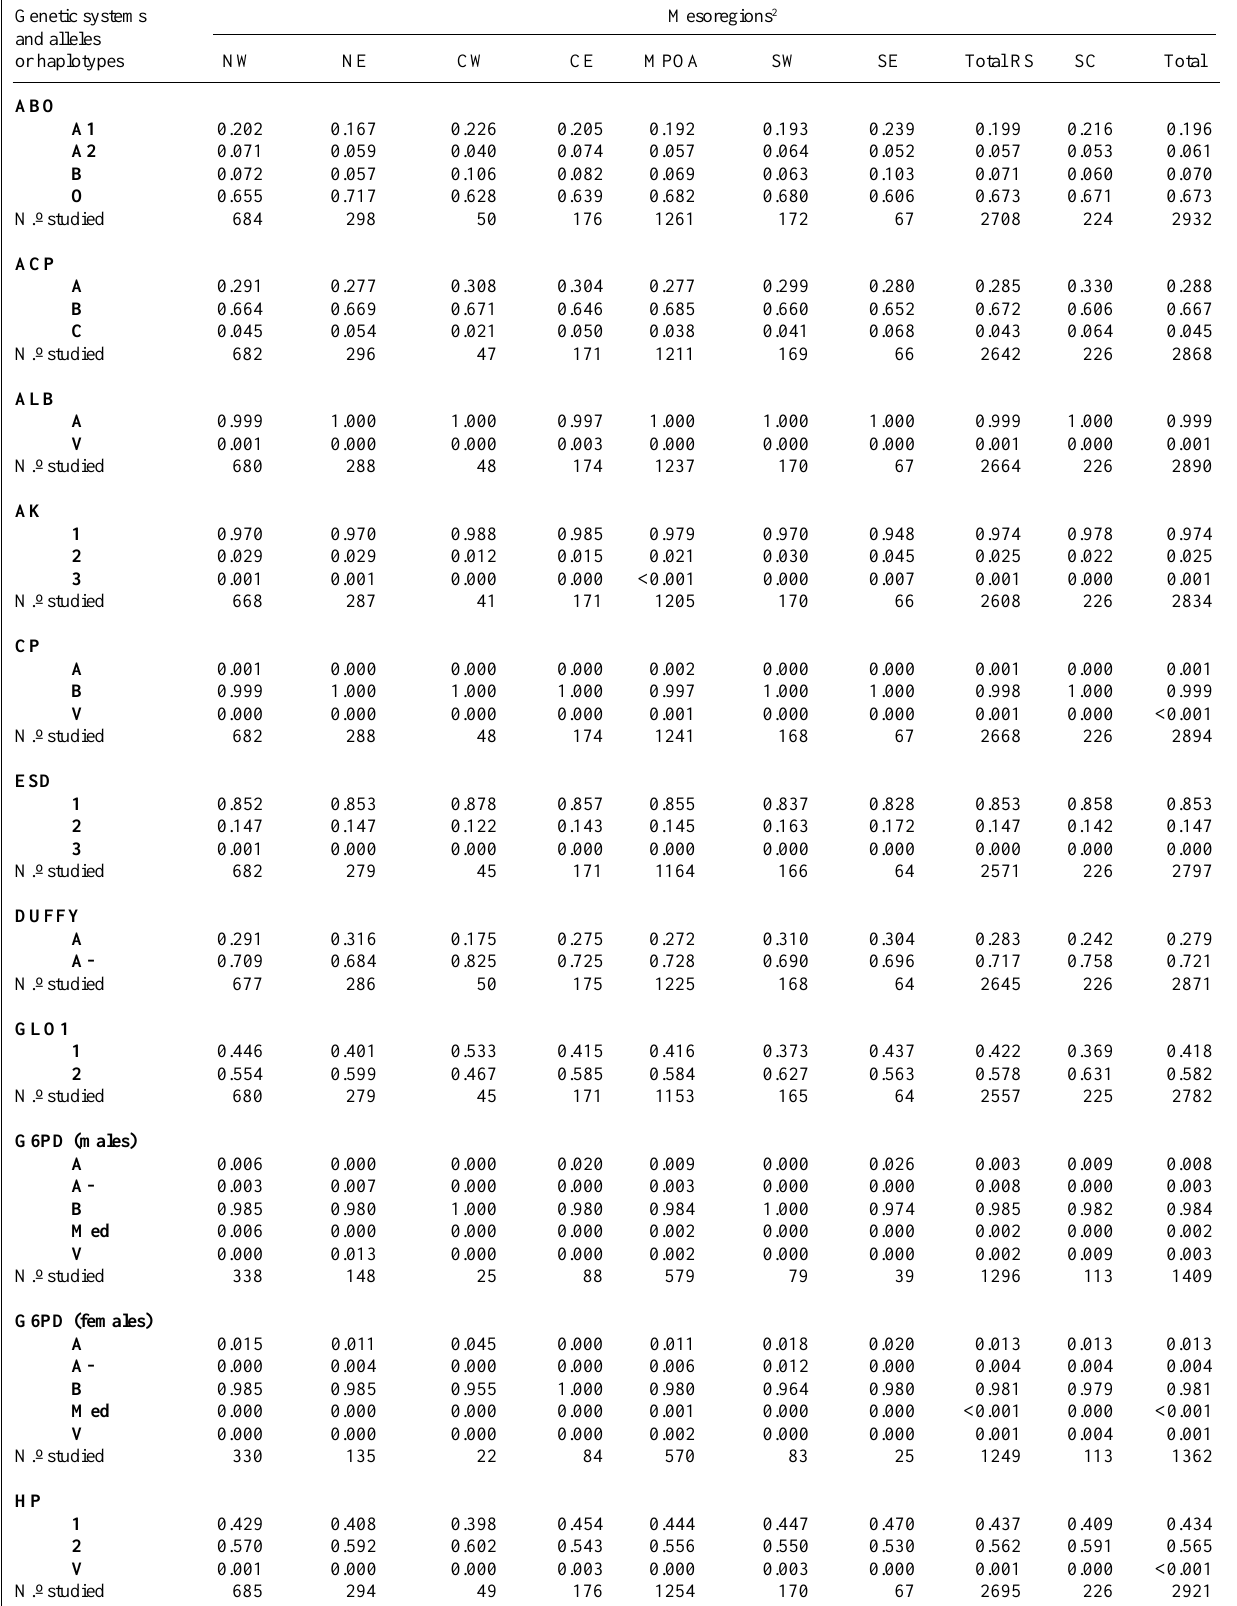
Table II - Allele frequencies for the 17 genetic systems studied in seven mesoregions of the State of Rio Grande do Sul (RS) and in Santa Catarina (SC) 1 . Genetic